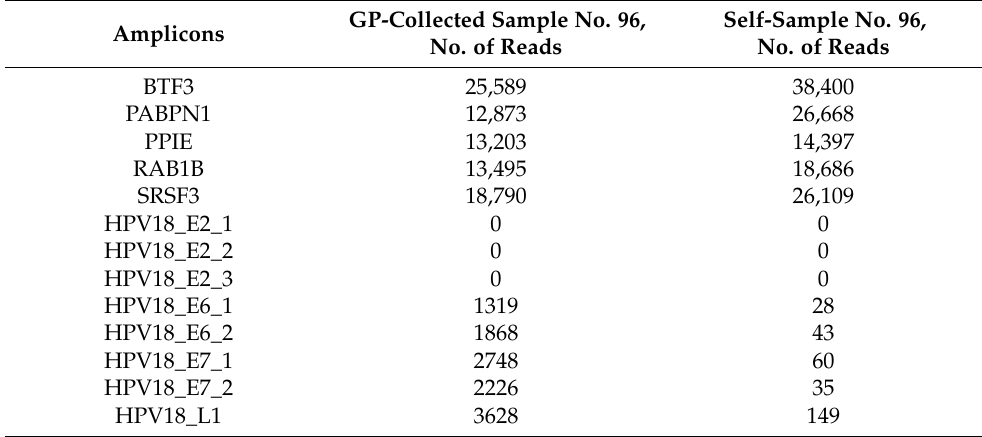
Table 5. NGS coverage data of an integrated HPV18 infection. GP-Collected Sample No. 96, Amplicons No. of Reads